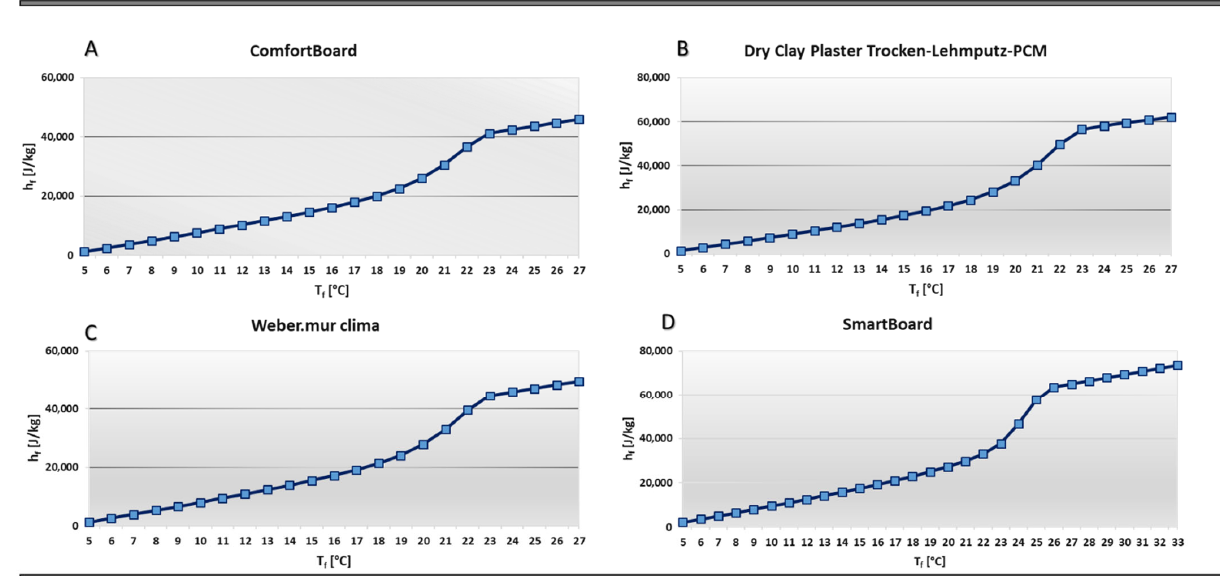
Figure 3. Enthalpy–temperature function: ( A ) Comfortboard ® ; ( B ) Weber.mur clima ® ; ( C ) Dry Clay Plaster; ( D ) SmartBoard TM . Table 2. Properties of building materials with microencapsulated PCM.